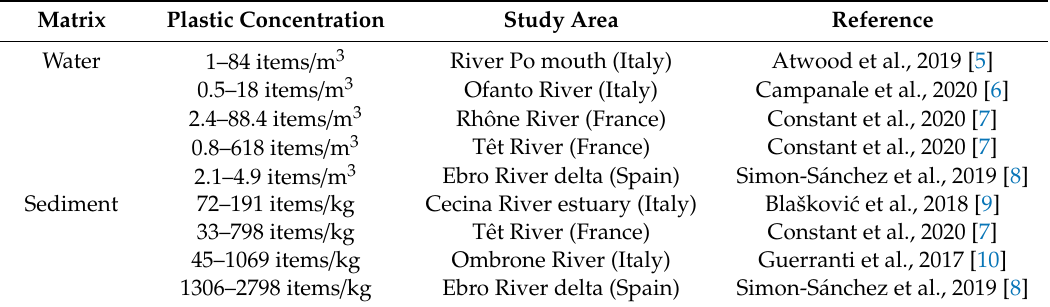
Table 1. Plastic concentration for water and sediment of rivers flowing into the Mediterranean